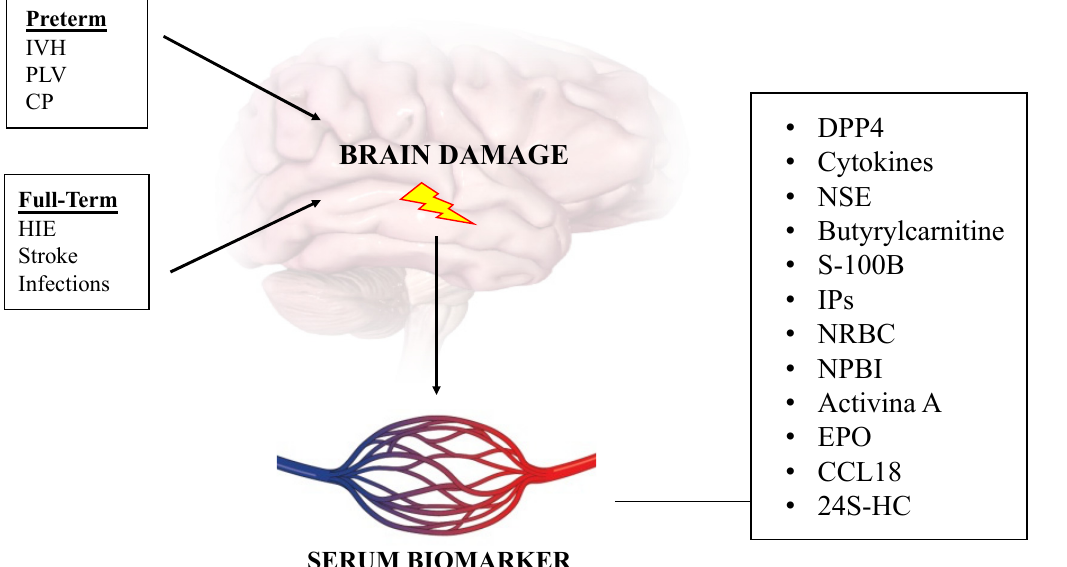
Figure 2. Newborn brain damage and serum biomarkers. Figure legend: IVH (intraventricular hemorrhage); PLV (periventricular leukomalacia); CP (cerebral palsy); HIE (hypoxic ischemic encephalopathy); DPP4 (dipeptidylpeptidase 4); NSE (neuron-specific enolase); S-100B (acidic calcium-binding protein); IPs (F2-isoprostanes); NRBC (nucleated red blood cells); NPBI (non-protein-bound protein); EPO (erythropoietin); CCL18 (chemokine ligand 18); 24S-HC